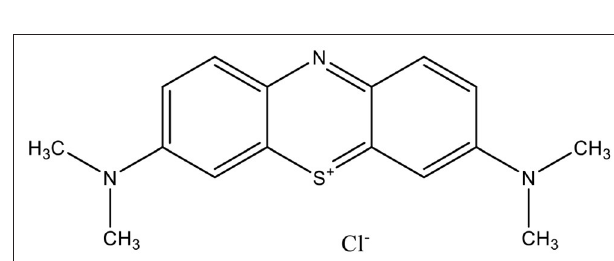
FIGURE 3 | Structure of